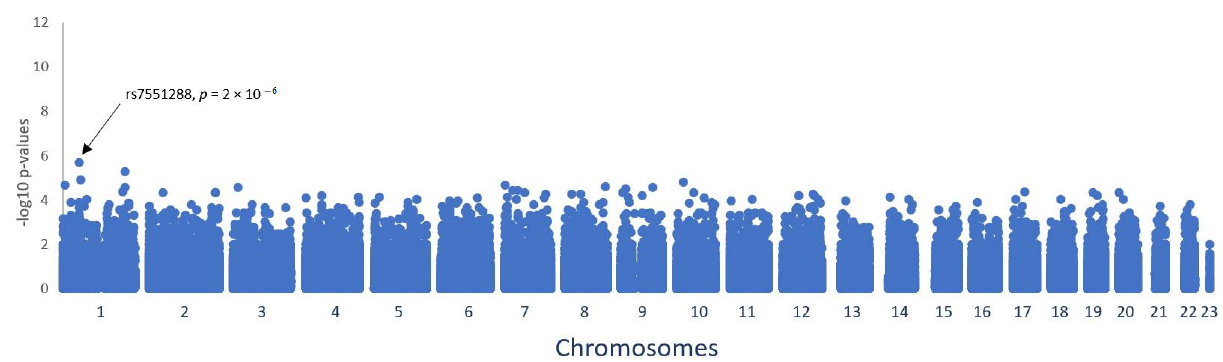
Figure 1. Manhattan plot illustrating the genome-wide association results of survival analyses in 556 melanoma patients from Germany. Each dot represents the −log10 p -value of the log rank test of the genotyped polymorphisms in association to the survival time of the patients. The dots are displayed on the x -axis according to the position of the polymorphisms on the 23 chromosomes. The SNP rs7551288 reached suggestive genome-wide significance with a p -value of 2 × 10 −6 . The polymorphism rs7551288 is a single-nucleotide polymorphism (SNP) with a sin- gle base change from guanine to adenine (G/A) in an intronic region of the DHCR24 gene. In the European population, the rs7551288*G allele has a higher frequency than the rs7551288*A allele. There are three different genotypes, the homozygous genotypes GG and AA and the heterozygous genotype GA with a rs7551288*G allele and a rs7551288*A allele. The minor allele frequency (MAF) of rs7551288*A was 0.43 in the assessed cohort from Germany. The rs7551288*A frequency was between 0.37 and 0.43 in European popula- tions, between 0.75 and 0.87 in Asian populations, and between 0.79 and 0.88 in